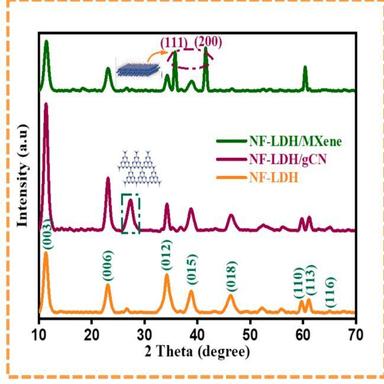
Graphical representation of XRD of fabricated photocatalysts.